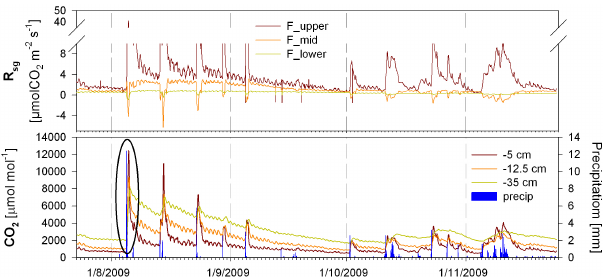
Fig. 10. CO 2 concentration profiles within (and 5cm above) the soil after the start of a larger rain event on 4th of August (also shown in Fig.